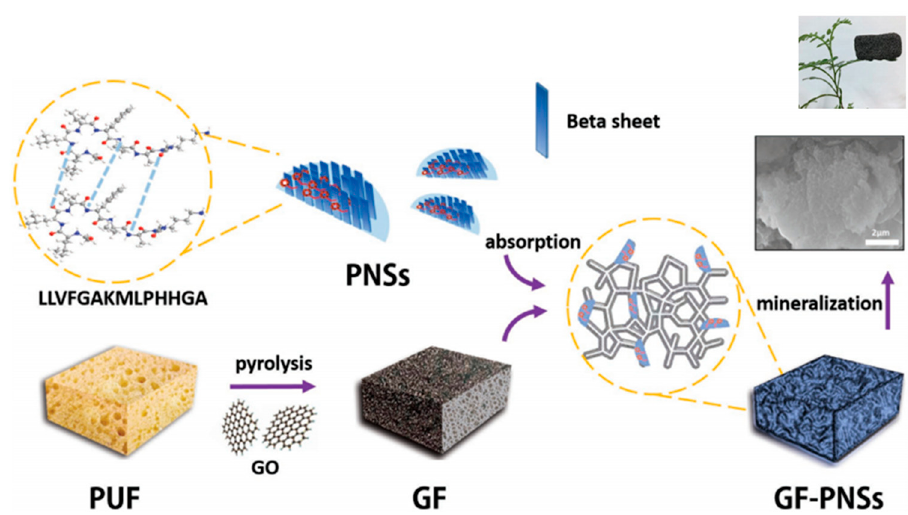
Figure 12. Biomimetic fabrication of 3D graphene (GF)-PNSs-HAp scaffold. PUF is a polyurethane foam used as a template for GF that can subsequently be removed from the flame, and GO is graphene oxide. Reproduced from [96]. PNS: peptide nanosheet.